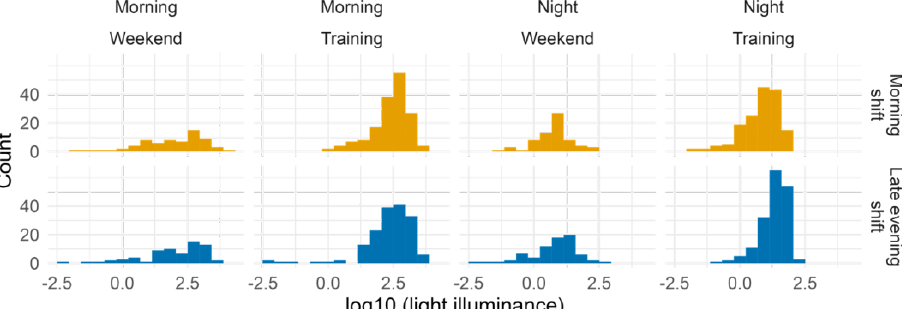
Figure A2. Illuminance distribution. Histograms showing the illuminance distribution ( n = 31; 483 observations in the morning window and 483 observations in the late evening window) by type of day (training/weekend), time window (morning: 08:30 to 12:29: late evening: 20:00 to 23:59; 483 ob- servations in the morning), and training shift (morning: 08:30 to 12:29: late evening: 20:00 to 23:59; 483 observations in the morning).